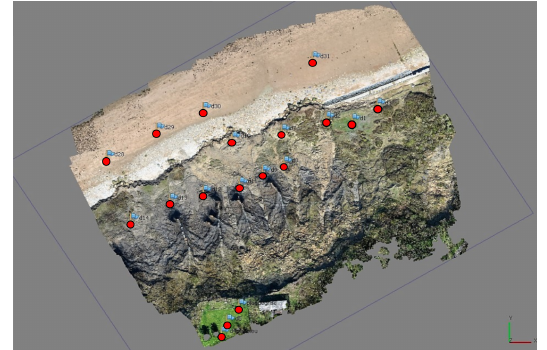
Figure 5. Location of the field targets used during the survey. The targets were positioned on the landslide as well as on the beach (upper part of the